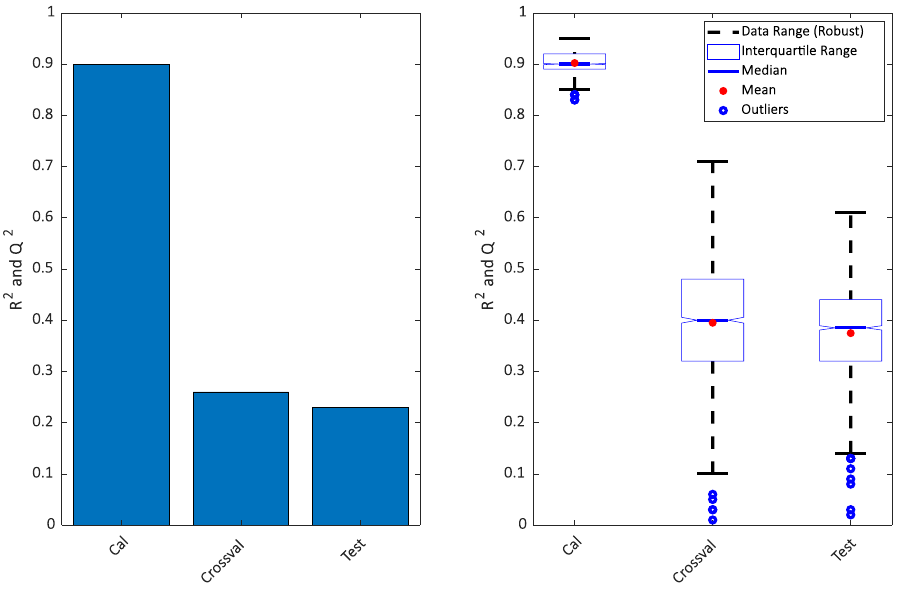
Figure 3. Variance described for the model plotted in Figure 2 (left) and repeated 500 times (right).